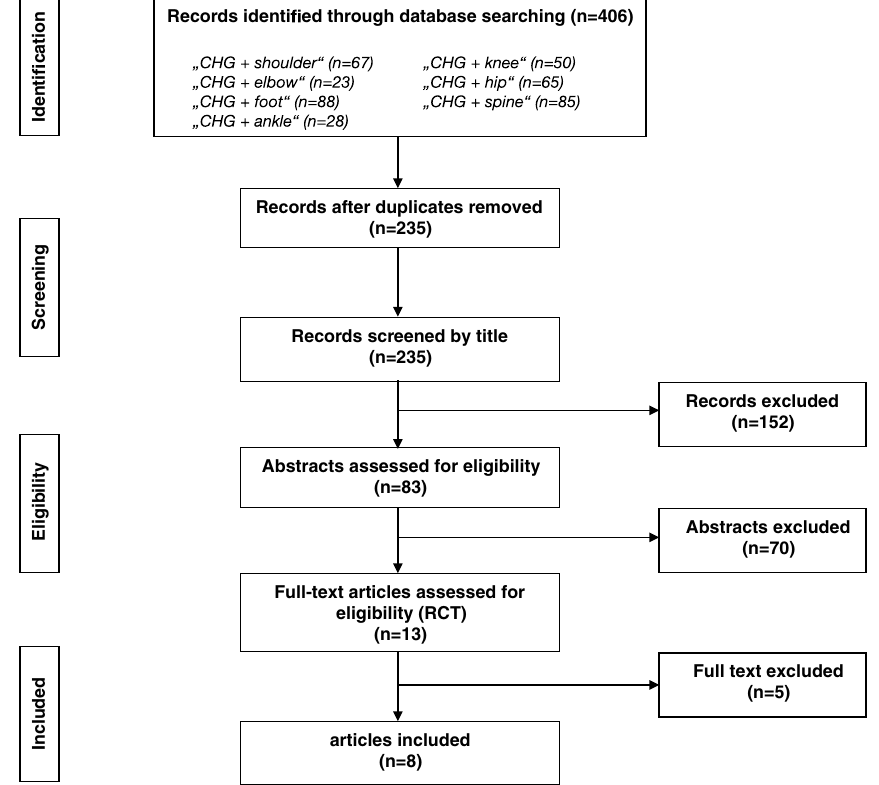
Figure 1. Flow diagram of literature search and study selection. CHG chlorhexidine, RCT randomized